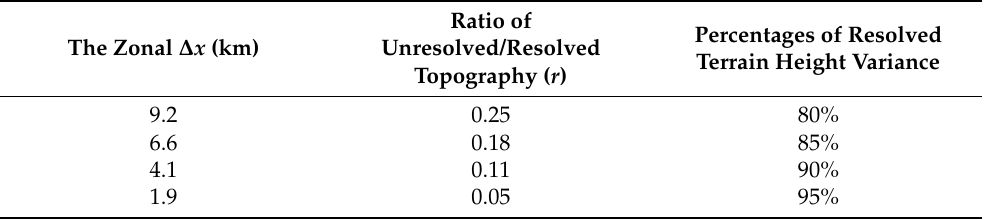
Table 4. The same as in Table 2, but n ∆ x = 133.6 km and δ x = 0.93 km. The Meridional ∆ x (km)